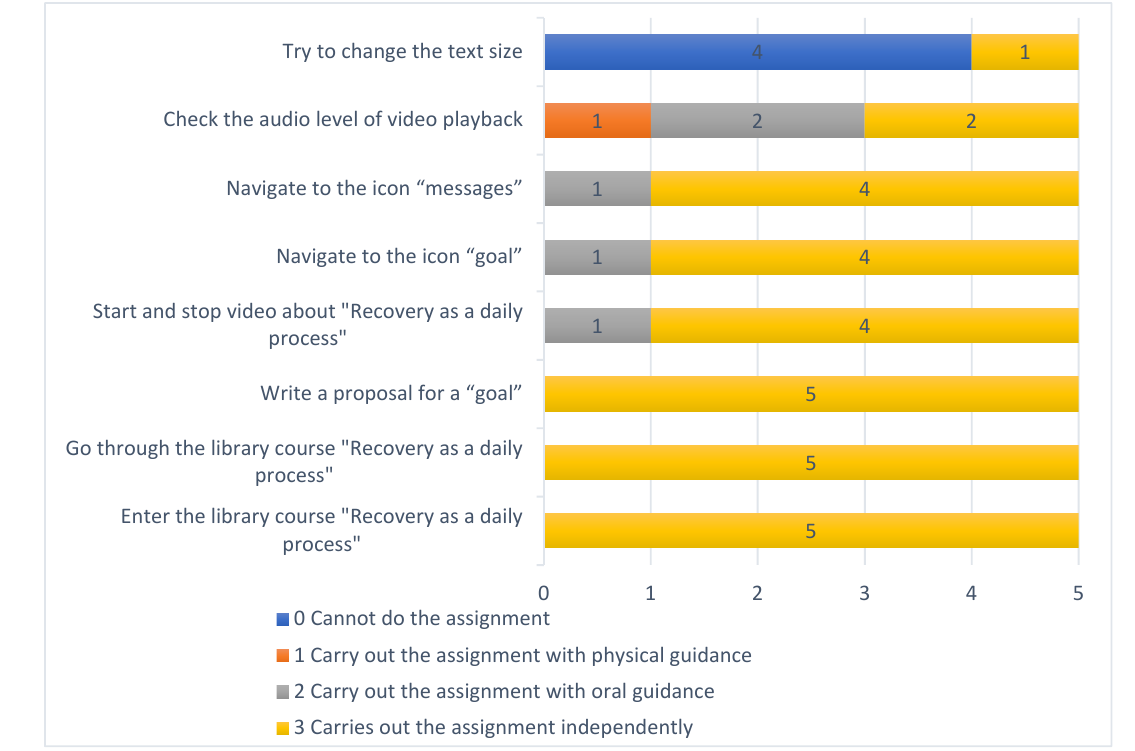
Figure 3. Task analysis of navigating the PeerTECH app.